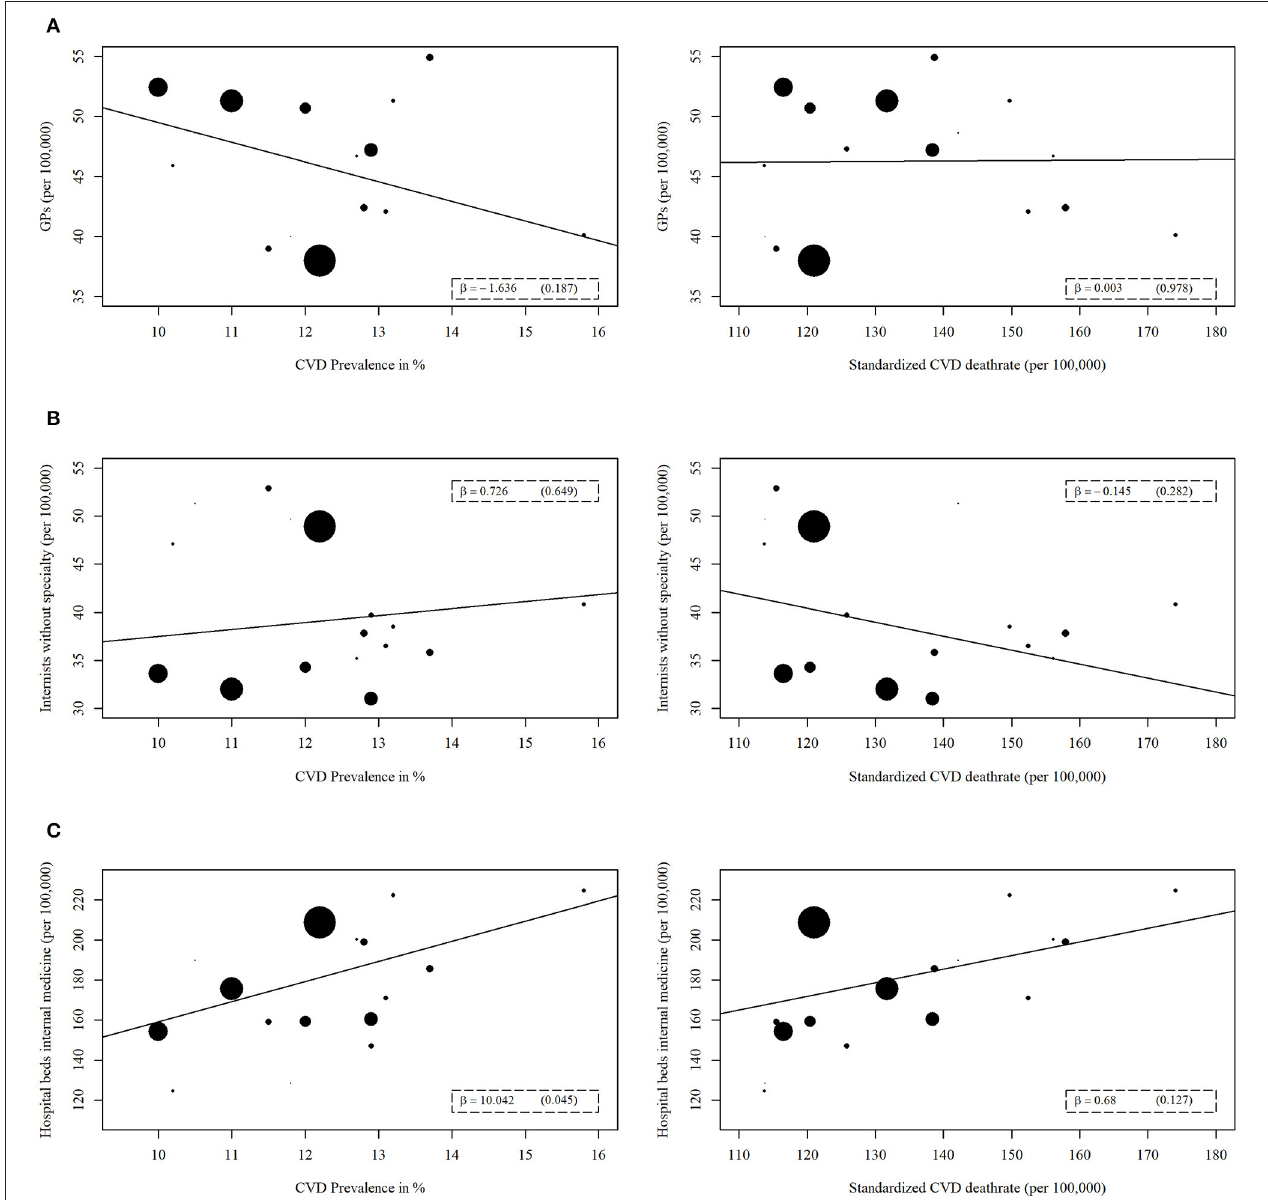
FIGURE 2 | Regression analyses of general health care supply indicators with prevalence or mortality of major cardiovascular disease (CVD). The general health care supply indicators are (A) Number of general practitioners (GP), (B) Number of internists without specialty, (C) Number of hospitals beds for internal medicine. A weighted linear regression was done for every association. The weight refers to the population size of each federal state. The size of the data points reflects the different